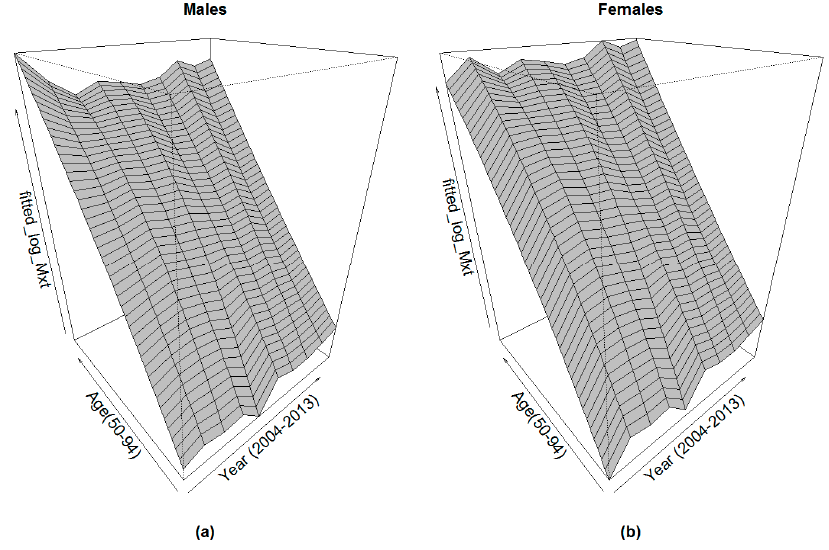
Figure 4. Experience crude mortality surface (ASDRs) issued from the retired population mortality data for: males ( a ); and females ( b ).